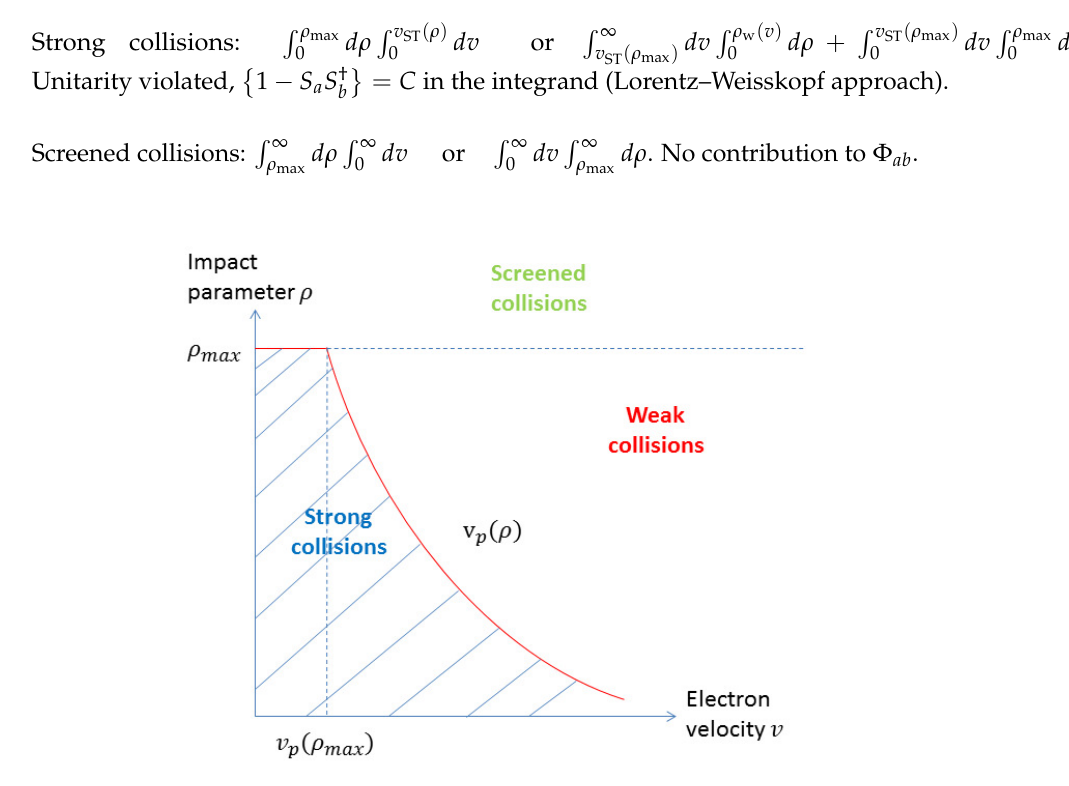
Figure 3. Simplified schematic representation of three different collisional regimes: screened, weak and strong in the ( ρ , v ) plane, ρ being the impact parameter and v the electron velocity. v p ( ρ ) represents the frontier between strong and weak collisions. It corresponds to